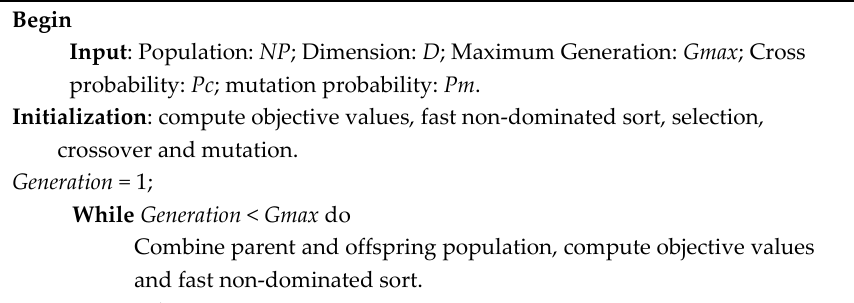
Algorithm 1 : The pseudo-code of